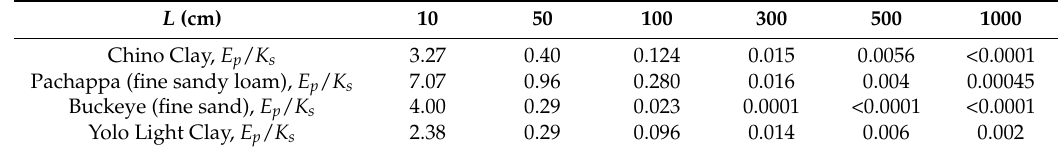
Table 2. The E p / K s values for different water table depths ( L ) and soil types. L (cm)